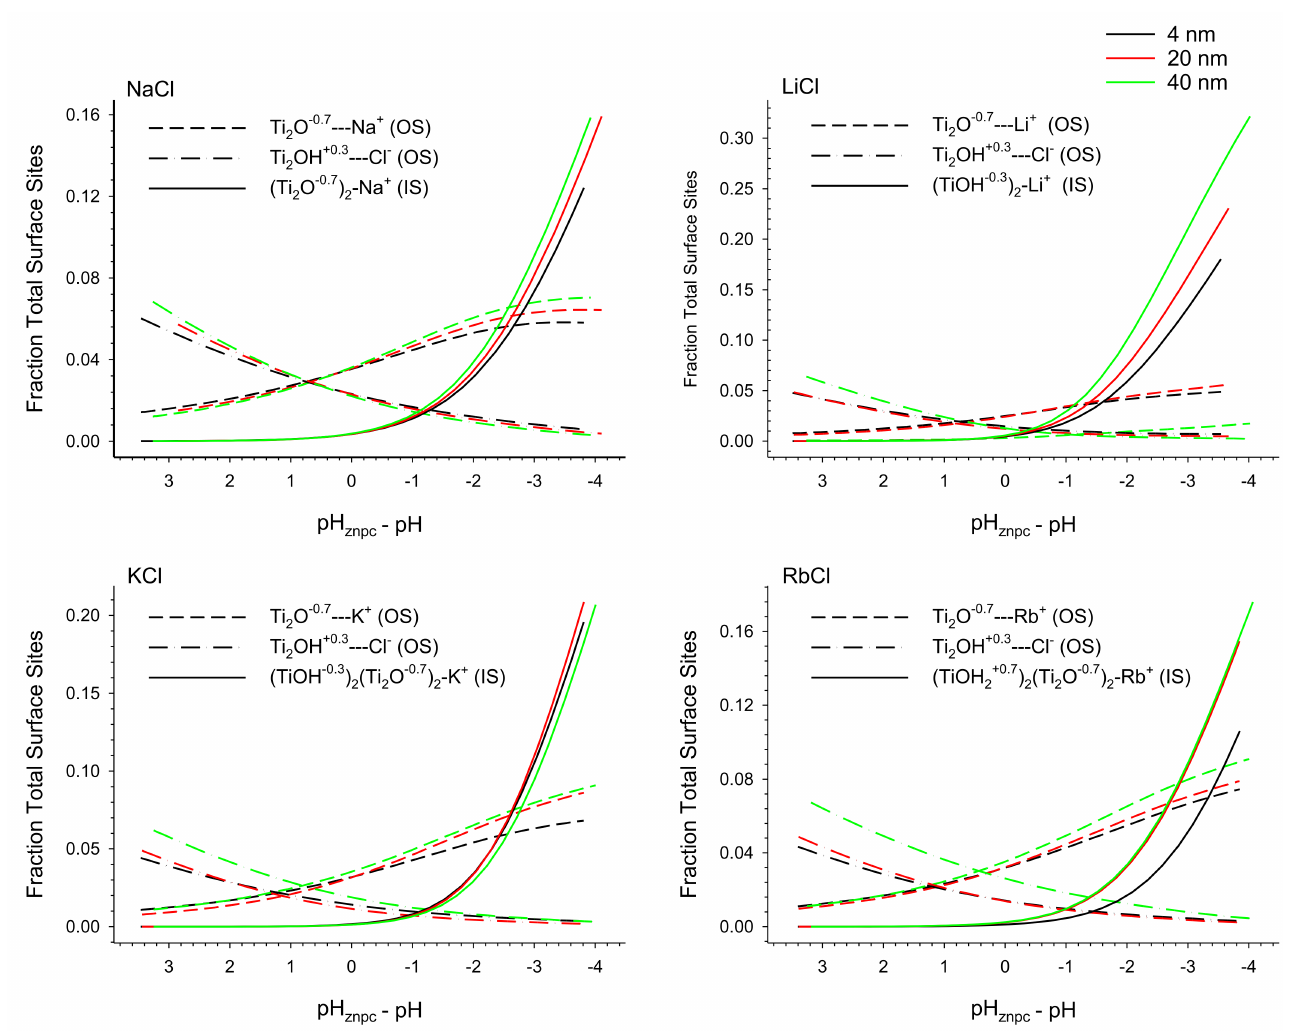
Figure 7. Effect of particle size on the distribution of surface species, as a function of pH znpc -pH. The black, red, and green lines represent particle sizes of 4, 20, and 40 nm, respectively. Data are presented for the inner-sphere and predominant outer-sphere electrolyte surface species, at 0.3 m ionic